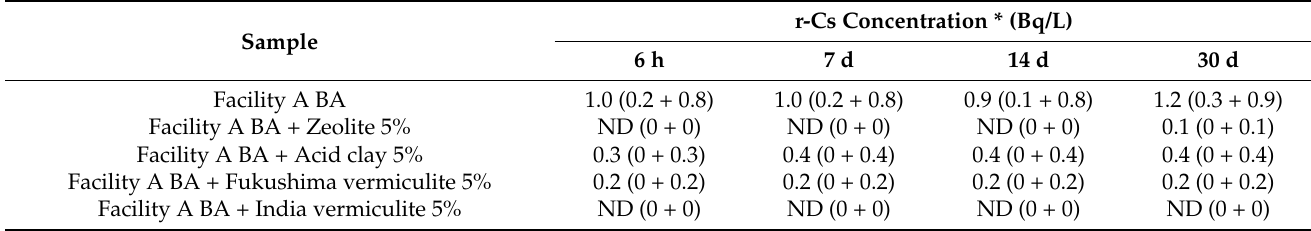
Table 10. Radioactive cesium (r-Cs) leaching test results (fly ash, FA + 5 wt.% clay minerals). Sample